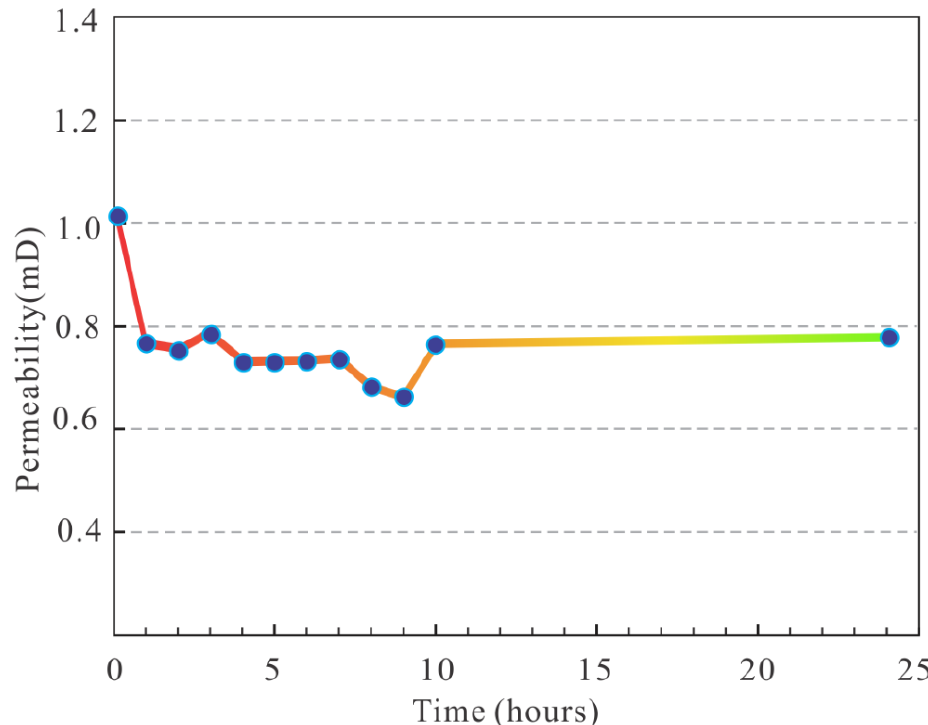
Figure 3. Permeability as a function of time for Sample 19 at a constant confining pressure (10 MPa) to assess any possible time dependence of sample permeability during loading – unloading cycles. to assess any possible time dependence of sample permeability during loading–unloading